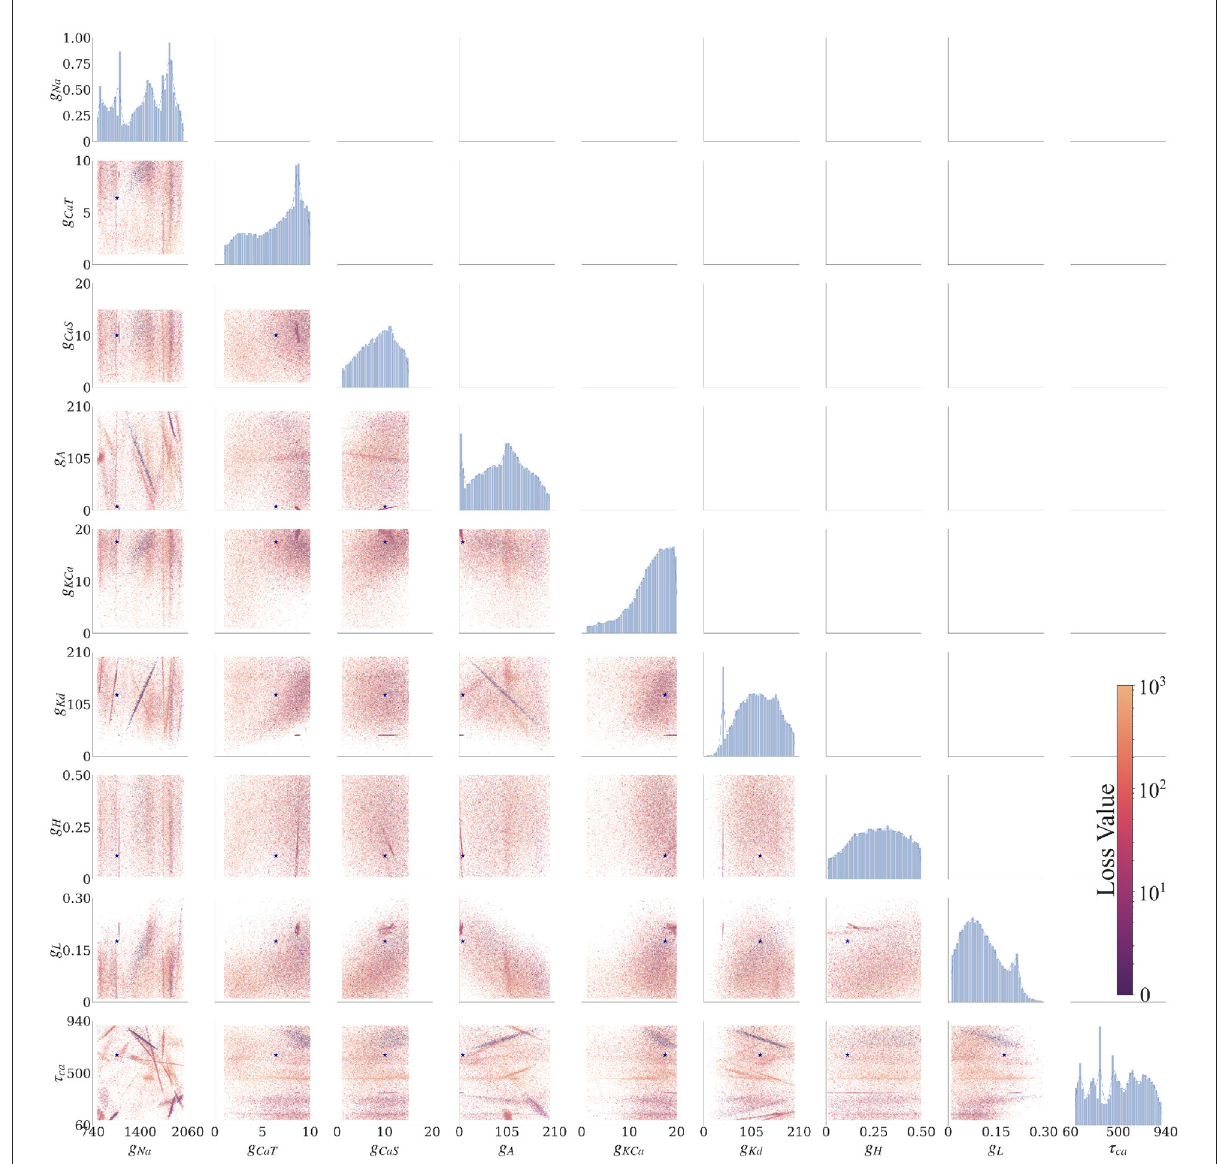
FIGURE3 Final solution map of the posterior for the 9 parameters of the AM model for the individual constraint of the 0.0 nA injected current. The diagonal plots show the 1D marginals of each parameter, where the x-axis is the search range of the parameter, and the y-axis is the normalized distribution. The remaining plots are the 2D marginals of pairs of parameters, where x- and y-axes are the range of the pairs of parameters. Each point within each plot is a sample found by the MCMC algorithm. The colors indicate the associated loss value of this sample, where the purple color indicates a lower loss value and the yellow color indicates a higher loss value. Density of points will contribute to the darkness of an area. The more pronounced a color signifies that more points are overlaid on top of each other. For example, in the top left 2D marginal [ g CaT , g Na ] the dark purple area around [ g CaT , g Na ] ∼ [9,1200] is an accumulation of many overlaid points. This density can also be traced back to the 1D marginals to the top and the left side. The ground truth values are plotted as a purple asterisk for comparison to low loss modes of the parameter